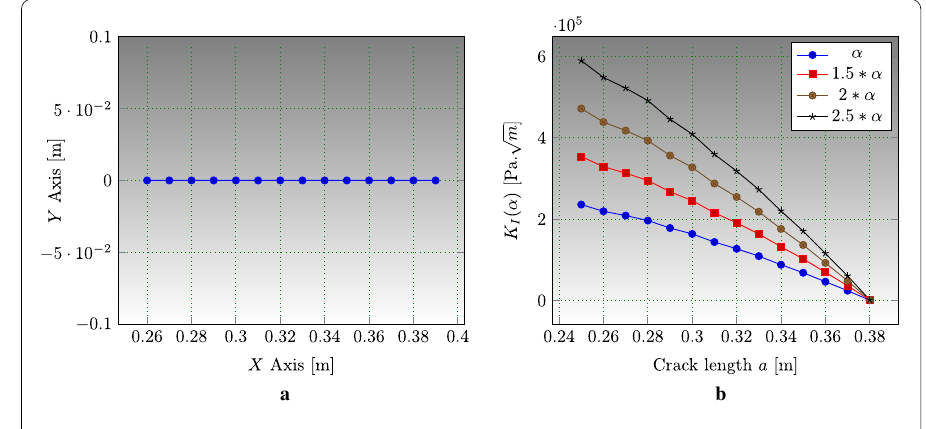
Fig. 22 Crack growth in edge cracked strip: a crack path, b influence of expansion coefficient on SIFs, K I